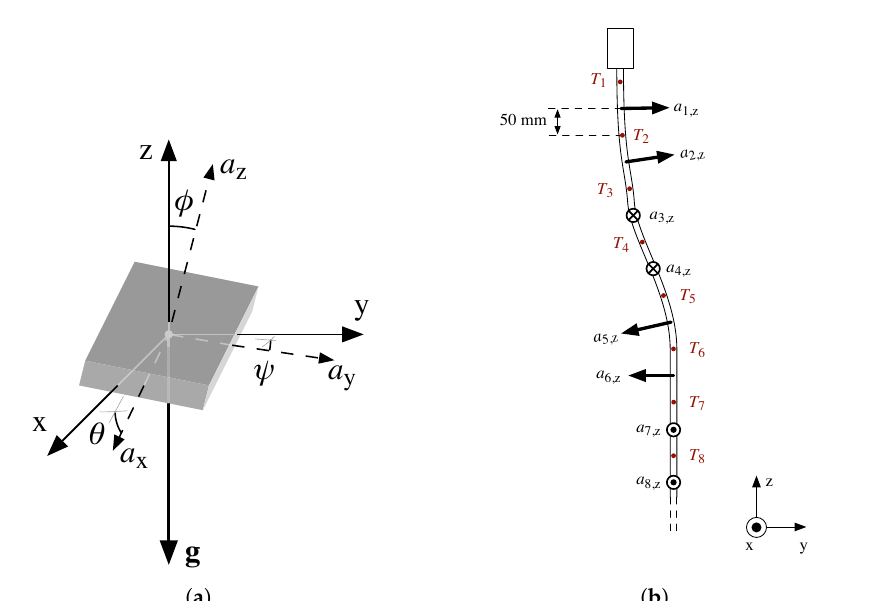
Figure 1. Accelerometer arrays can be used for deformation measurements. ( a ) Inclination mea- surement with an accelerometer and ( b ) design of the probe with temperature sensors ( T i ) and accelerometers ( a i